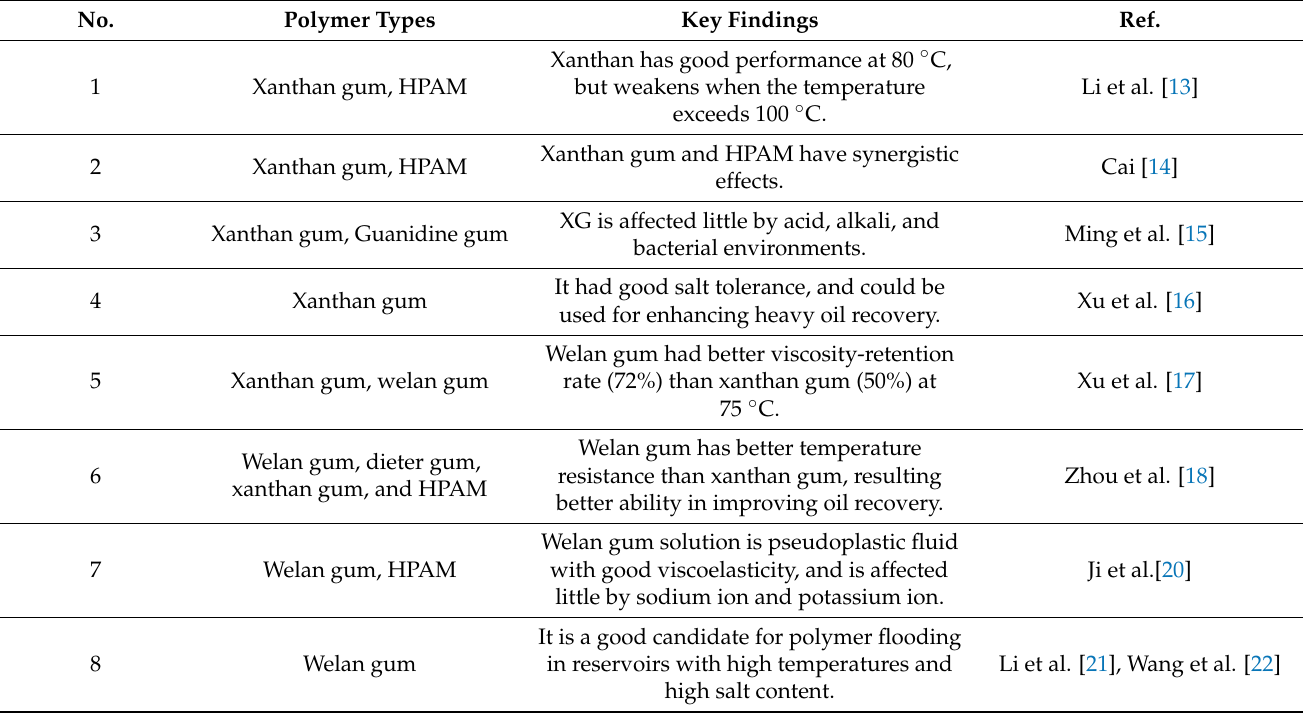
Table 1. Typical studies of microbial polysaccharide used in polymer